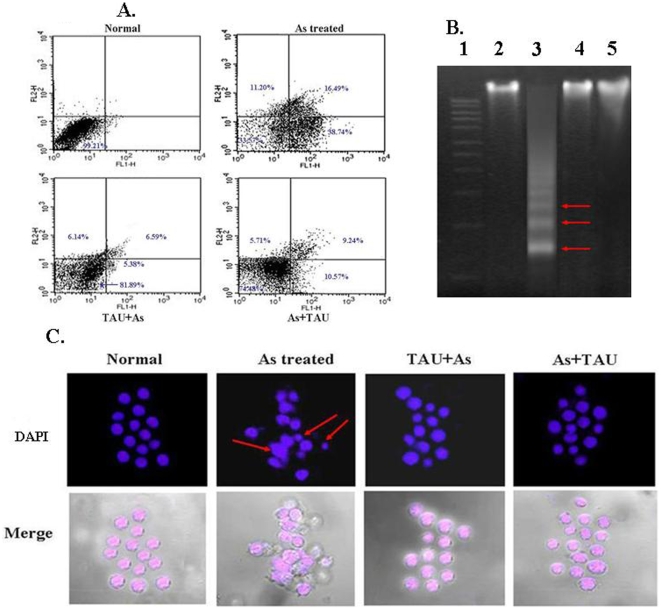
Mode of cell death in absence (As) and presence of taurine (TAU+As and As+TAU).Fig. A: percent distribution of apoptotic and necrotic cells. Cell distribution was analysed using Annexin V binding (taken as x axis) and PI uptake (taken as y axis). The FITC and PI fluorescence were measured using flow cytometer with FL-1 and FL-2 filters respectively. Results expressed as dot plot representing as one of the six independent experiments. Fig. B: DNA fragmentation pattern on agarose/EtBr gel. DNA isolated from experimental liver tissues was loaded onto 1% (w/v) agarose gels. Lane 1: Marker (1 kb DNA ladder); Lane 2: DNA isolated from normal liver; Lane 3: DNA isolated from As intoxicated liver; Lane 4: DNA isolated from taurine pretreated liver samples, Lane 5: DNA isolated from taurine post-treated liver samples. Arrows indicate ladder formation in DNA isolated from NaAsO2 intoxicated animals. Fig. C: DAPI staining. Cell nuclei of untreated or As and taurine treated hepatocytes were visualized following DNA staining with the fluorescent dye DAPI and were observed using a microscope (original magnification ×20). The measurements were made in six times. Arrows indicate fragmented and condensed DNA in hepatocytes.